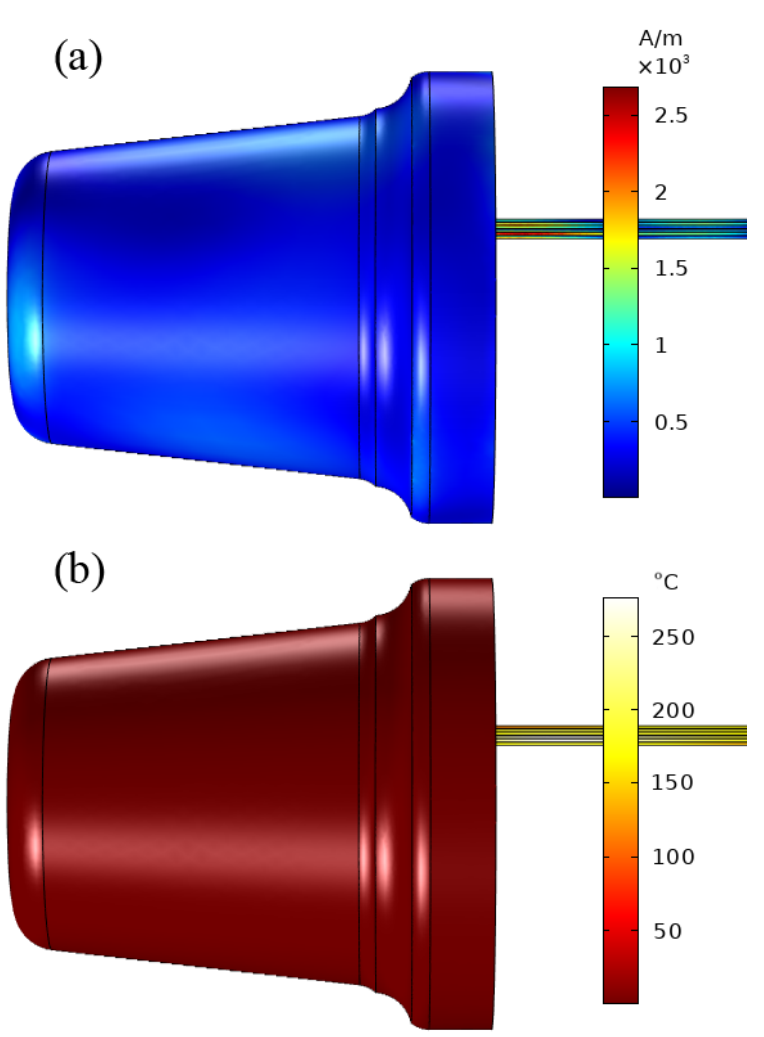
Figure 2. Electromagnetic–thermal distribution on the FTU: ( a ) magnetic field distribution on the FTU; ( b ) thermal distribution on the